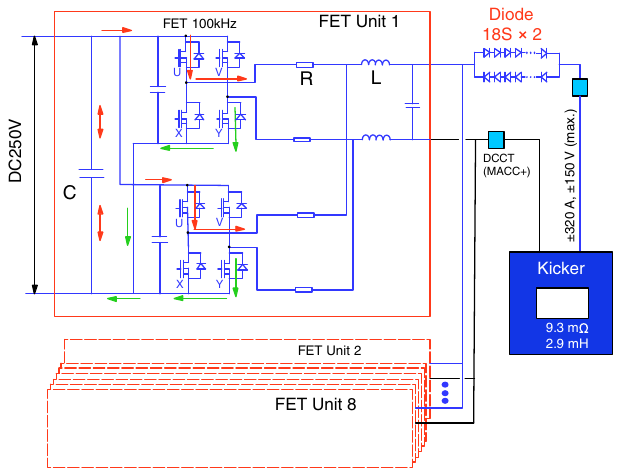
FIG. 4. Block diagram of the kicker magnet power supply. FET units are water cooled.